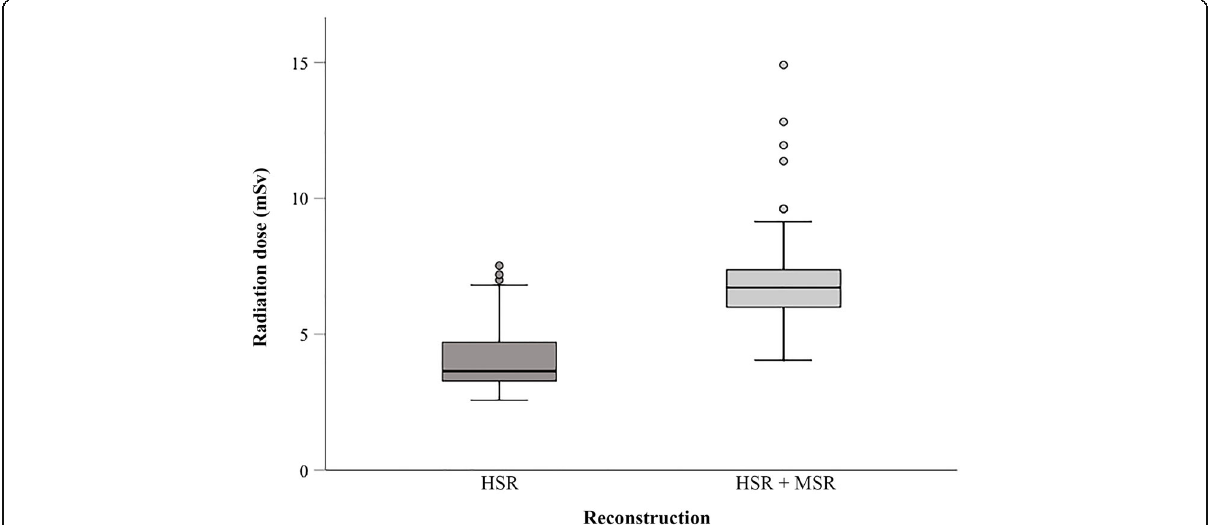
Fig. 5 Boxplots showing estimated radiation dose in mSv of stress computed tomography perfusion in patients with multisegment acquisition, which allowed both MSR and HSR (93 patients), and in patients with HSR only (41 patients). Boundaries of boxes represent the lower and upper quartiles and horizontal lines in boxes the medians. Outliers are depicted as individual open circles. In the HSR-only group, MSR was not possible in 9 patients despite multisegment acquisition of two segments. Mean radiation dose of patients with both MSR and HSR was higher than that of patients with HSR ( p < 0.001). HSR Halfscan reconstruction, MSR Multisegment